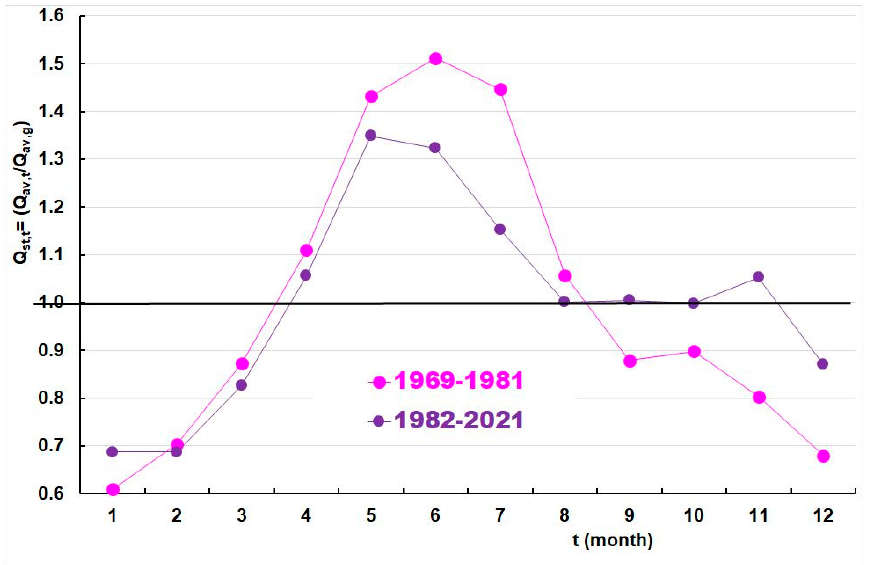
Figure 12. Graphical representation of the values of the standardized, average monthly flows of the Drava near Botovo, Q st,t , during the following two subperiods: (1) 1969–1981 (light purple color); (2) 1982–2021 (dark purple color).